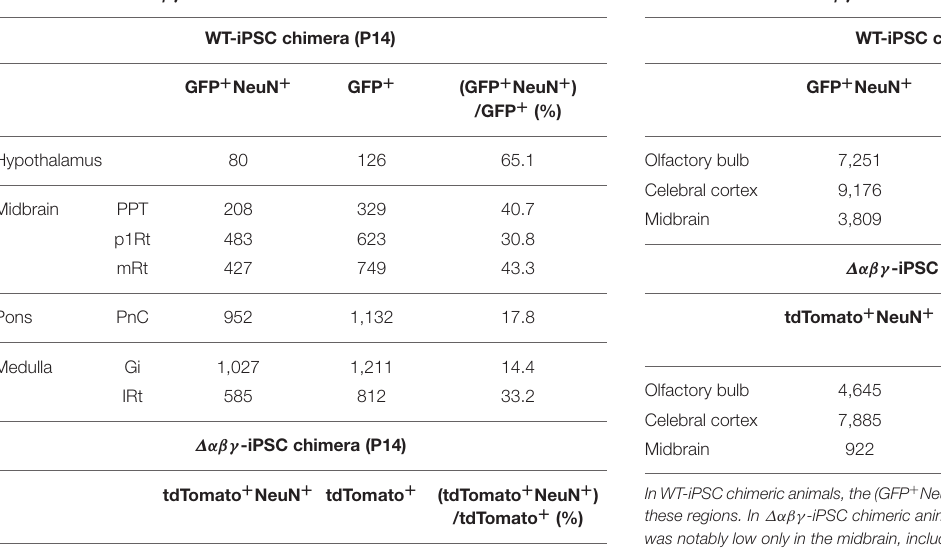
TABLE 2 | Survival ratio of chimeric populations (GFP + in the WT-iPSC chimera and tdTomato + in the ∆αβγ -iPSC chimera) and neuronal populations (NeuN + ) in the olfactory bulb, cerebral cortex, and midbrain of the WT-iPSC and ∆αβγ -iPSC chimeric